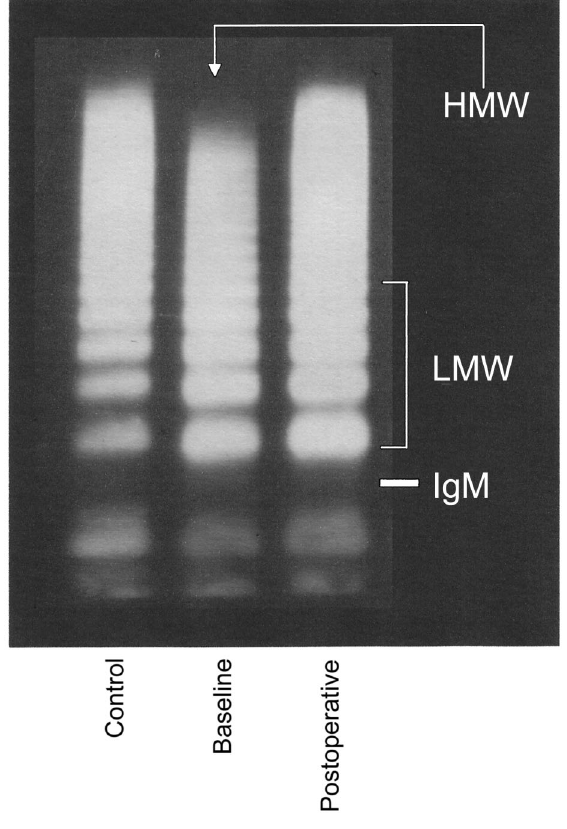
Figure 1. Representative Western immunoblot showing plasma von Willebrand factor multimeric structure (pattern observed in 36 of 48 children with cyanotic congenital heart disease). At baseline, reduction of high molecular weight multimers (HMW), with increased density of low molecular weight fractions (LMW, five bands migrating just above IgM) compared with control plasma (relative optical density of LMW multimers 0.44 (0.11- 0.56) and 0.36 (0.25-0.55), respective median value and range in patients and controls, P = 0.0081). Postoperatively, the density of LMW fractions remained high [0.45 (0.17-0.63), P = 0.5360 versus baseline]. The migration of immunoglobulin M (IgM, 950 kDa) is